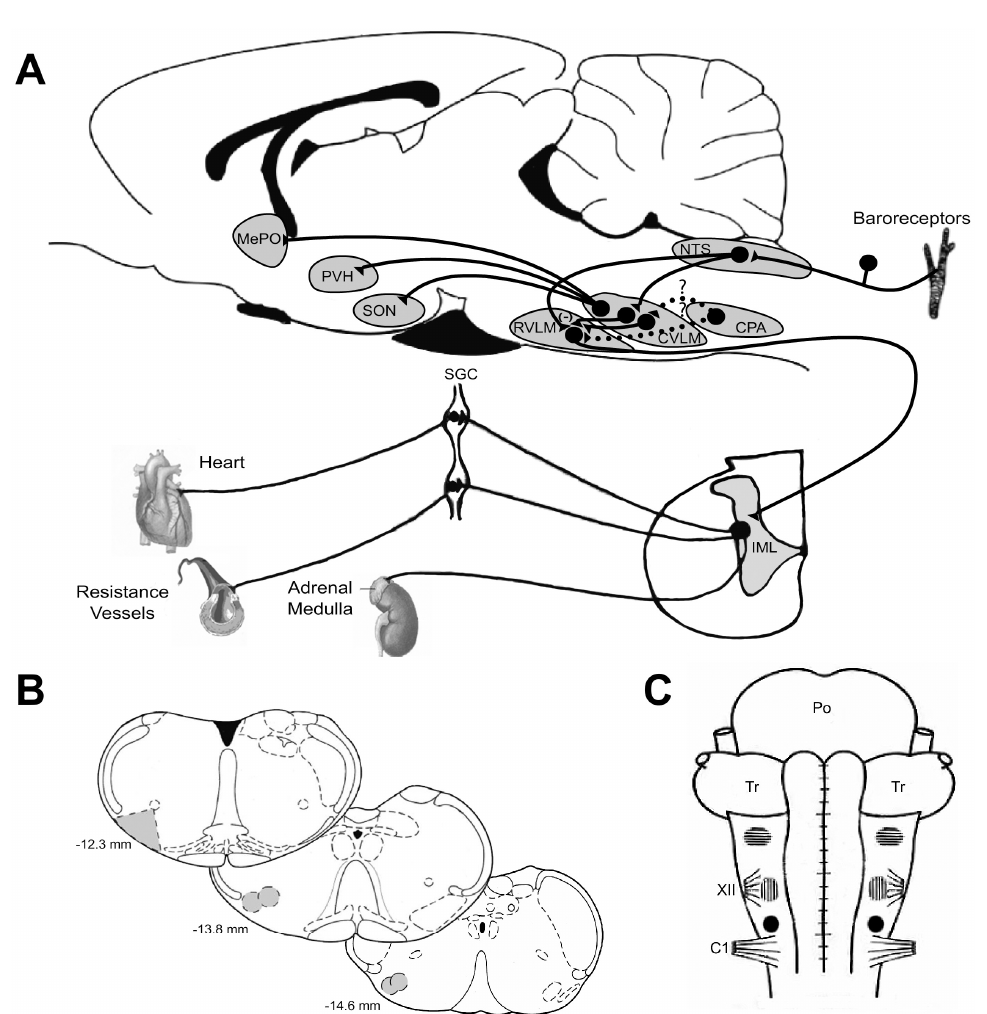
Fig. 1 – A: The current view of the role of the ventrolateral medulla and cardiovascular regulation: tonic sympathetic activity to the heart, resistance vessels and adrenal medulla derive from preganglionic sympathetic neurons (SPNs) located in the intermediolateral cell column. SPNs are tonically excited by direct bulbospinal neurons located in the rostral ventrolateral medulla (RVLM). Activity of RVLM neurons is regulated by inhibitory afferents located in the caudal ventrolateral medulla (CVLM) and by activity of neurons in caudal pressor area (CPA). The nucleus tractus solitarius (NTS) is the primary site receiving afferents from high and low pressure baroceptors and chemoreceptors. From the NTS this informationistransferredtotheVLM.ArterialbaroreceptorsreflexesaremediatedbytheinhibitoryCVLM-RVLMpathway. FromCVLascending efferents project to several nuclei involved in water and salt intake and cardiovascular control, e.g., the Median Preoptic Nucleus (MePO), the paraventricular nucleus of hypothalamus (PVH) and the supraoptic nucleus (SON). B: Schematic representation of three coronal sections of the rat medulla oblongata at the levels of the RVLM, CVLM and CPA, respectively. The hatched areas represent the areas from which characteristic cardiovascular responses can be evoked. C: Diagram representing the rat’s ventral medullary surface showing the localizations (from rostral to caudal) of the RVLM, CVLM and caudal pressor area (CPA) (Modified from Cravo et al.